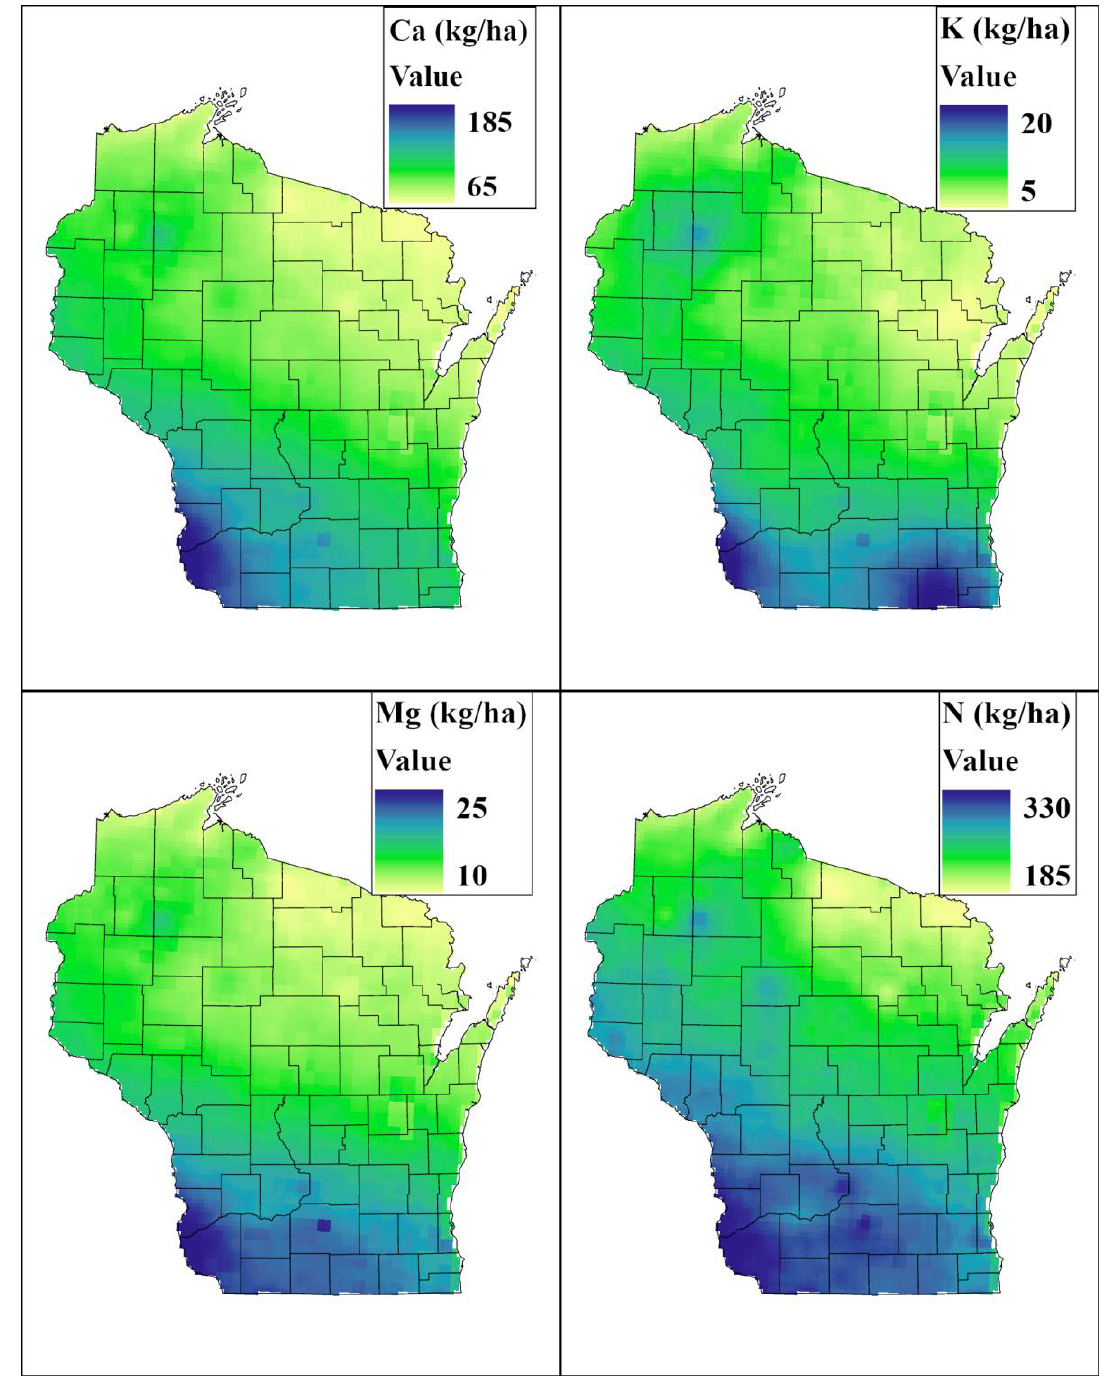
Figure A1. Total atmospheric deposition (wet + dry) throughout one 45-year rotation (adapted from [25]) of nutrients across the state of Wisconsin. In general, the south and southwestern areas are receiving two to three times the amount in the northeastern area.